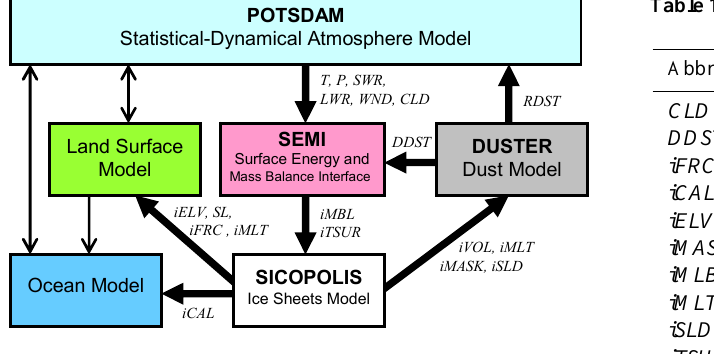
Fig. 1. Flow diagram of the model version used in this study. Thick arrows represent new flows of information compared to the “stan- dard” version of CLIMBER-2 described in Petoukhov et al. (2000). Abbreviations are explained in the Table 1.